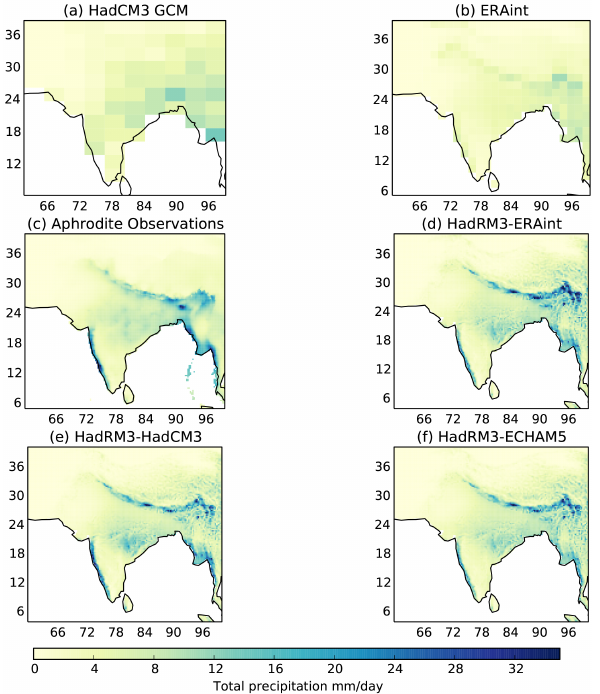
Figure 3. The spatial distribution of the seasonal mean total pre- cipitation for the monsoon period (June, July, August, September) for the HadCM3 GCM (a) , ERAint (b) , APHRODITE observa- tions (c) and the three HadRM3 simulations: HadRM3-ERAint (d) , HadRM3-HadCM3 (e) and HadRM3-ECHAM5 (f)